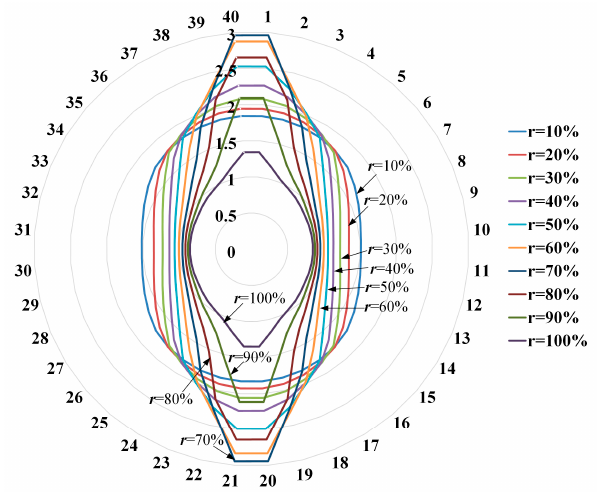
Figure 7. Evolution of point safety factor with the excavation load releasing, number of 1–40 showing the elements’ location around a